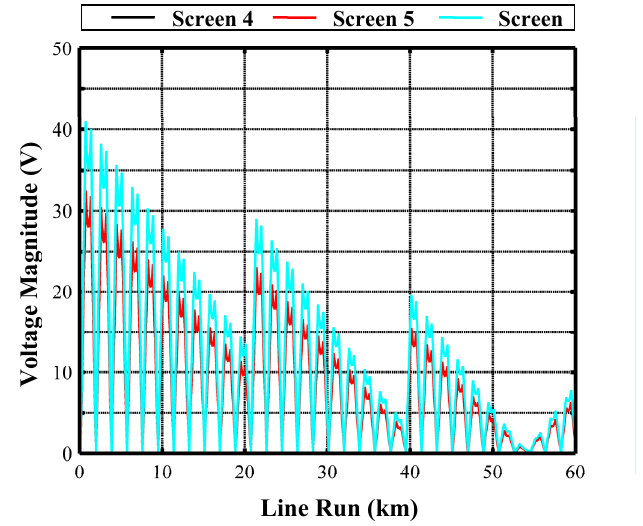
Figure 13. Screen voltage magnitudes along the compensated single-circuit cable in CB with PTs at